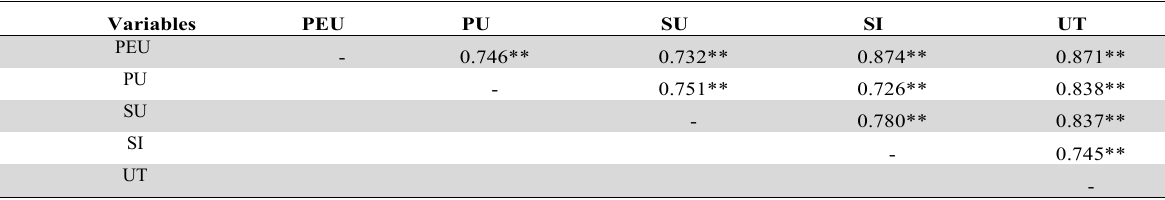
Pearson Correlation between Variables